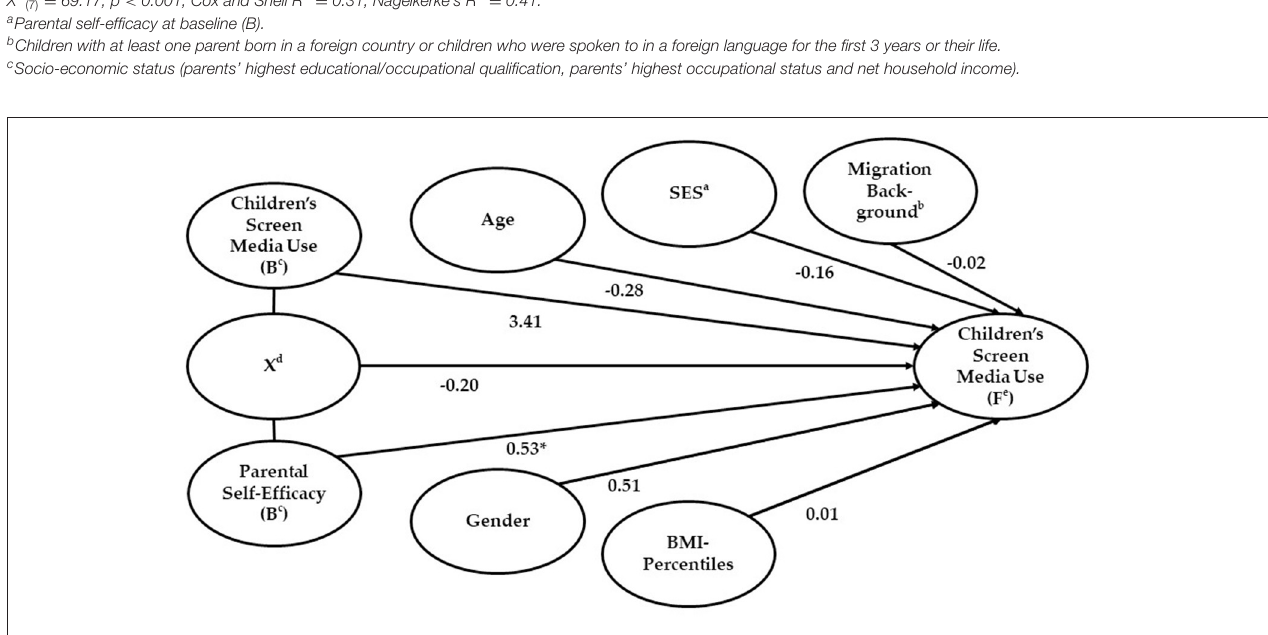
Migration background b